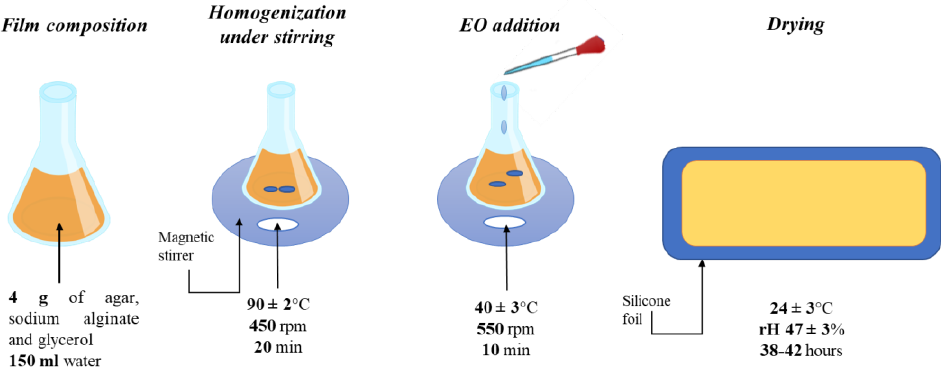
Figure 4. Diagram of schematic preparation process.